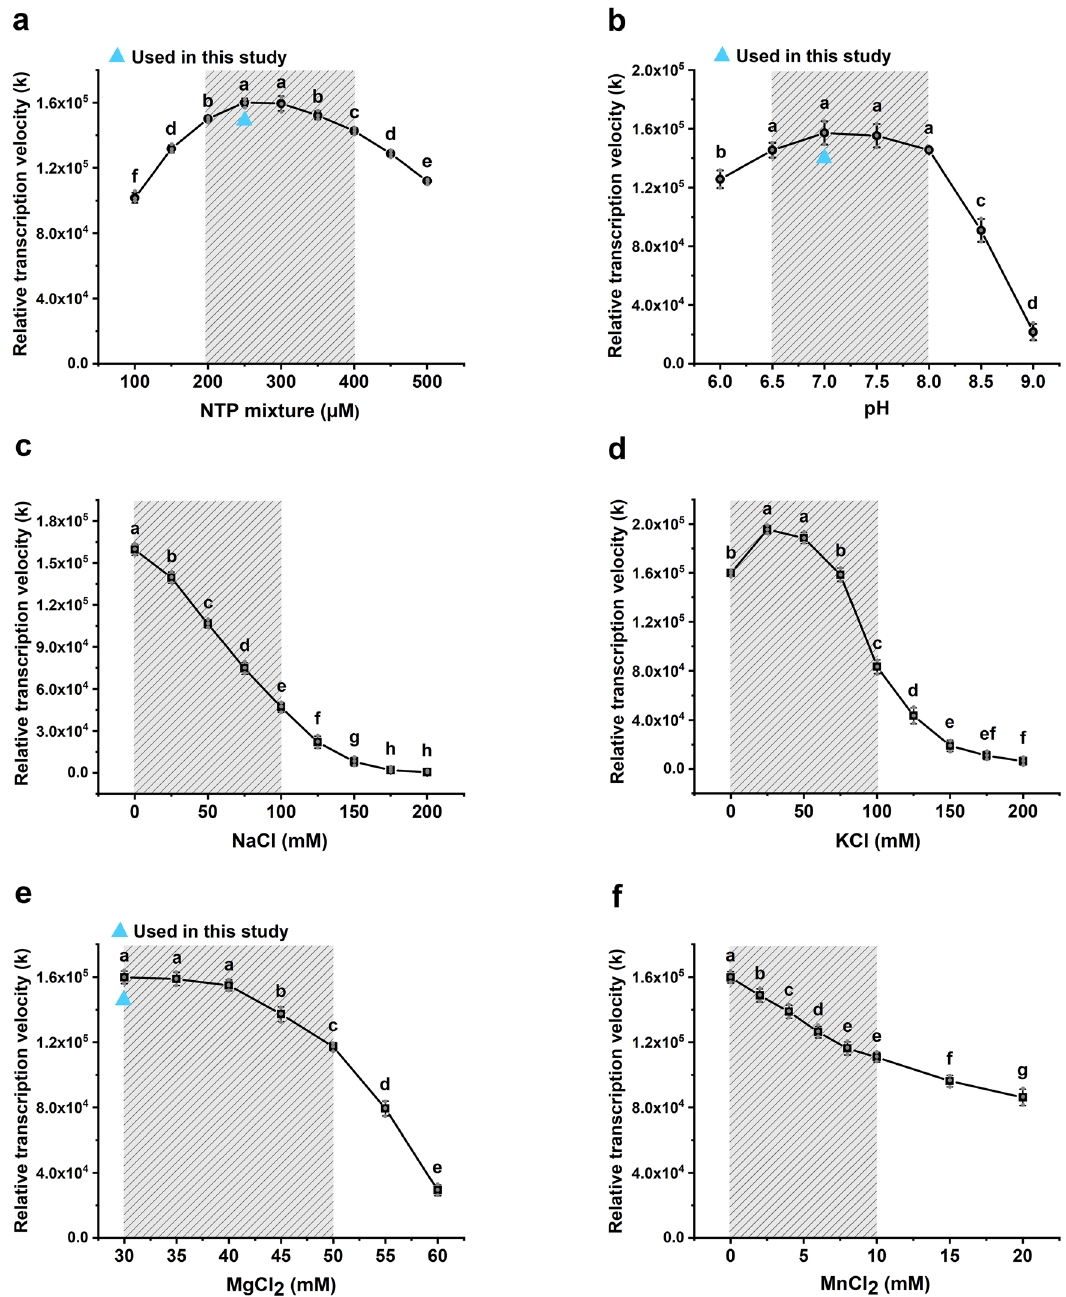
Fig. 4 Effects of reaction buffers on RT-IVT assays. The relative initial transcription velocity of T7 RNA polymerase at different NTP ( a ), pH ( b ), NaCl ( c ), KCl ( d ), MgCl 2 ( e ), and MnCl 2 ( f ) concentrations. The shaded areas represent the common concentration range for each ion, and triangles represent the ion concentrations used. The values shown were the mean ± standard deviation of three repeats. Different letters indicate signi fi cant differences among NTP, pH, or ion treatments according to Duncan ’ s test ( p < 0.05, n =